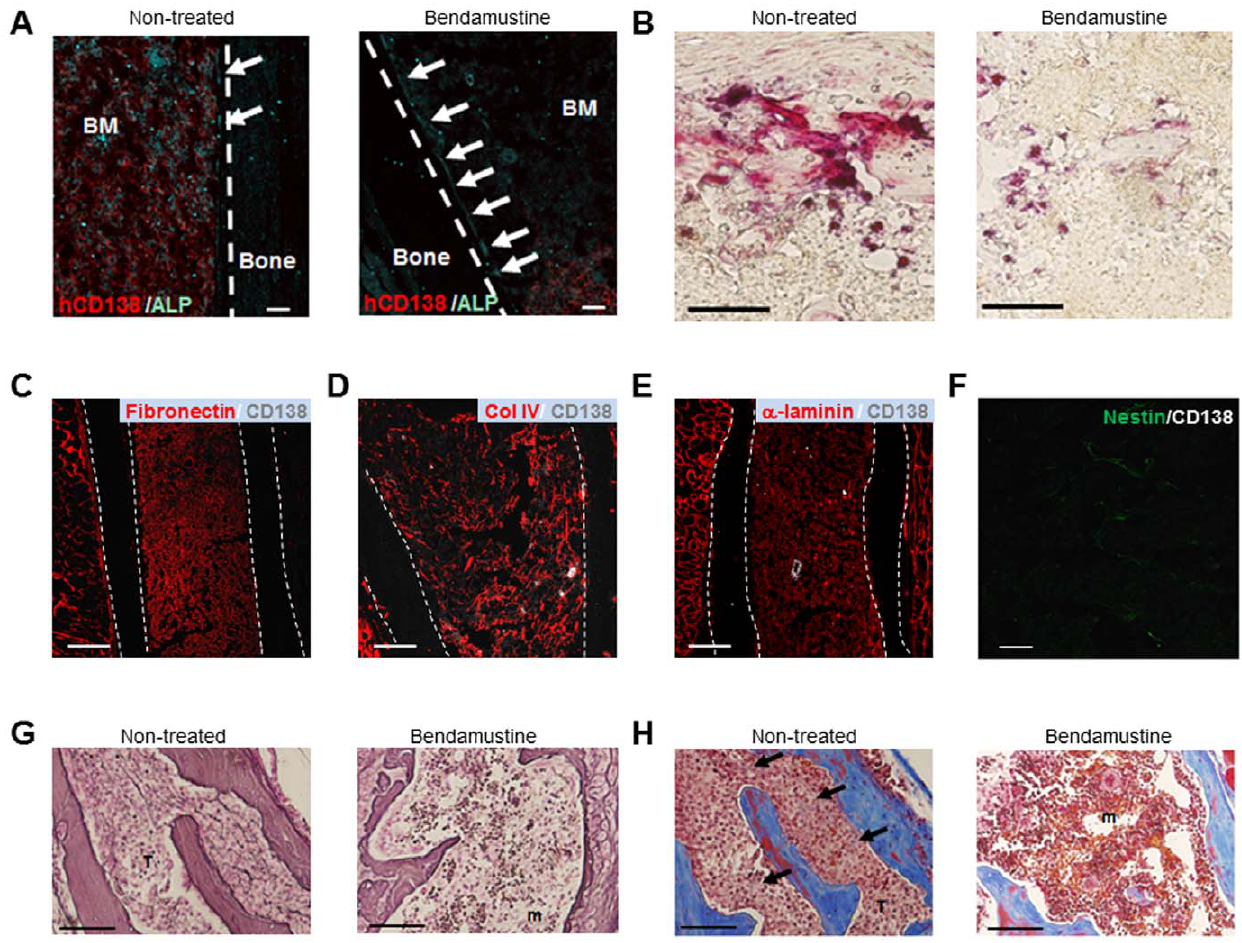
Figure 6. Bendamustine maintains the normal BM niche invivo . A. Double IHC of human CD138 (red) and ALP (cyan) at 4 weeks after treatment in bendamustine-treated mice (right panel) or non-treated mice (left panel). The arrows indicate the osteoblast lining on the bone surface. Representative data from seven fields of the BM of two mice per group from two independent experiments are shown. Bars=60 m m. B. Representative photomicrographs of TRAP staining of the metaphyseal region of the femur at 4 weeks after treatment in bendamustine-treated mice (right panel) or non-treated mice (left panel). Representative data from three fields from the BM of four non-treated mice or two bendamustine- treated mice from two independent experiments are shown. Bars=100 m m. C–E. Double IHC of fibronectin (red; C ), type IV collagen ( D ) or a -laminin ( E ) with human CD138 (gray) at 4 weeks after bendamustine treatment. Representative data from five fields of the BM of two bendamustine-treated mice from two independent experiments are shown. Bars=200 m m. F. Double IHC of nestin (green) and human CD138 (gray) at 4 weeks after bendamustine treatment. Representative data from five fields of the BM of two bendamustine-treated mice from two independent experiments are shown. Bar=40 m m. G. Histological studies of the thoracic vertebrae of NOG mice 4 weeks after treatment in bendamustine-treated mice (right panel) or non-treated mice (no treatment; left panel). Reticulin staining: T, tumor; m, marrow. Representative data from five fields of the BM of five mice per group from two independent experiments are shown.Bars=100 m m. H. Histological studies of the thoracic vertebrae of NOG mice 4 weeks after treatment in bendamustine-treated mice (right panel) or non-treated mice (left panel). Masson trichrome staining: T, tumor; m, marrow. Representative data from five fields of the BM of five mice per group from two independent experiments are shown. Bars=100 m